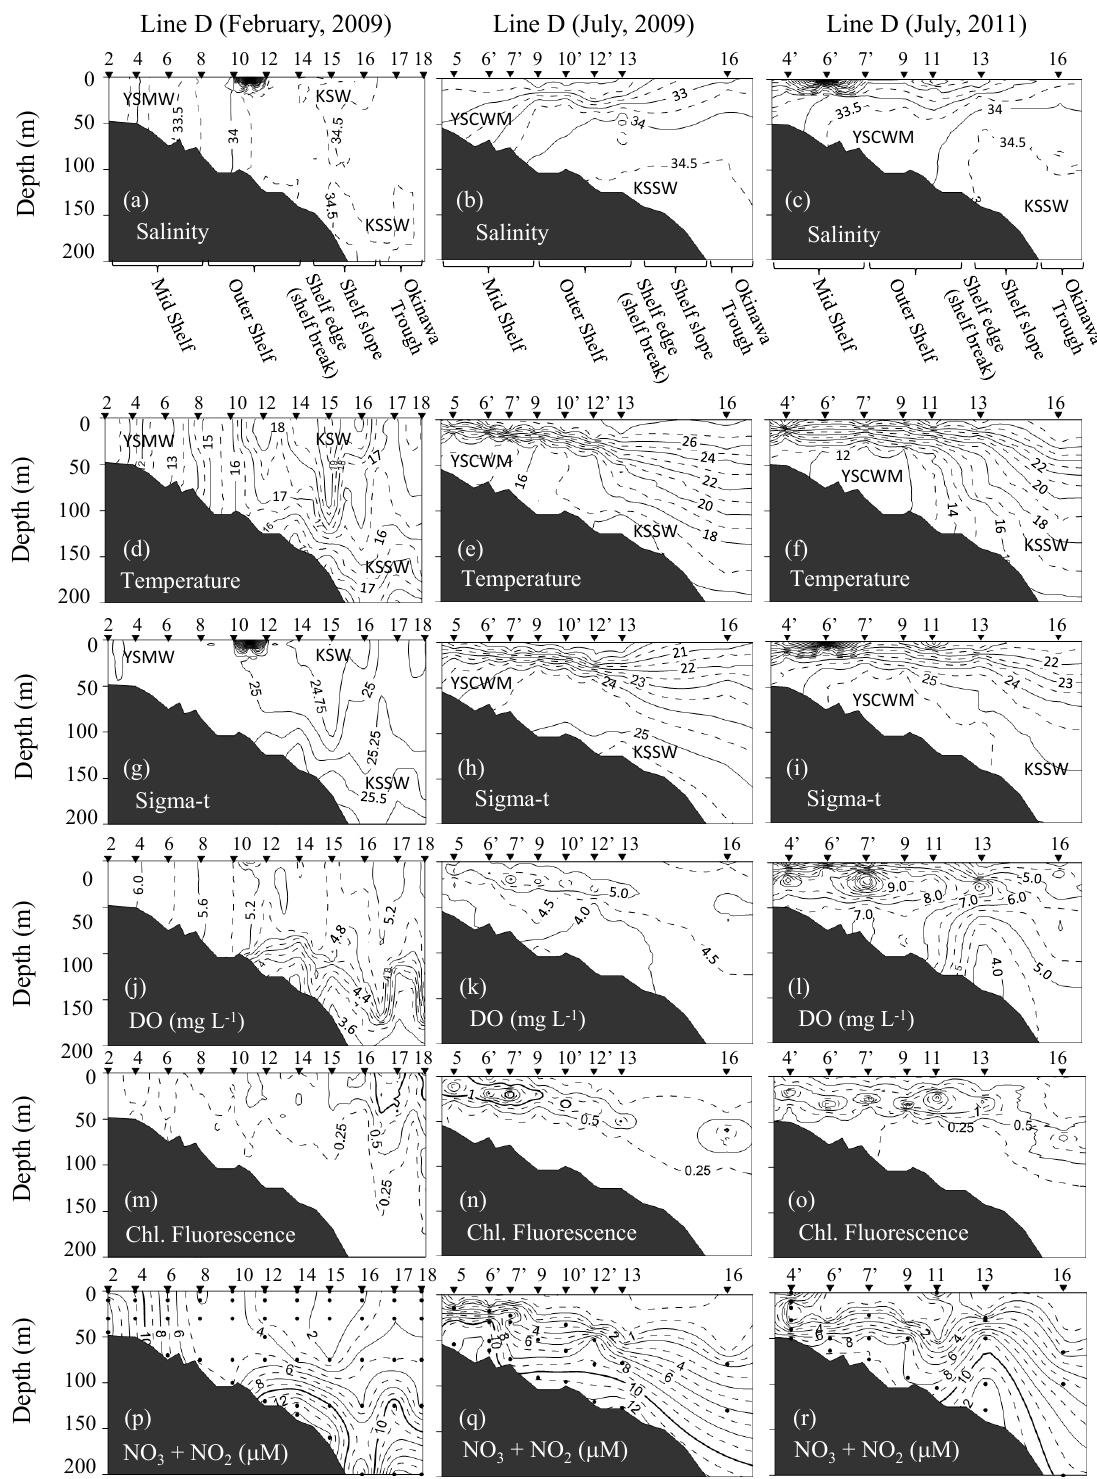
Figure 2 (Umezawa et al.) Fig. 2. Vertical distribution of physical parameters, chlorophyll fluorescence, and nitrate concentrations along Line D in February and July 2009 and July 2011. The black circles in the NO 3 +NO 2 figure indicate the location where NO 3 concentration was more than 1.5µM, and δ 15 N and δ 18 O in NO 3 were